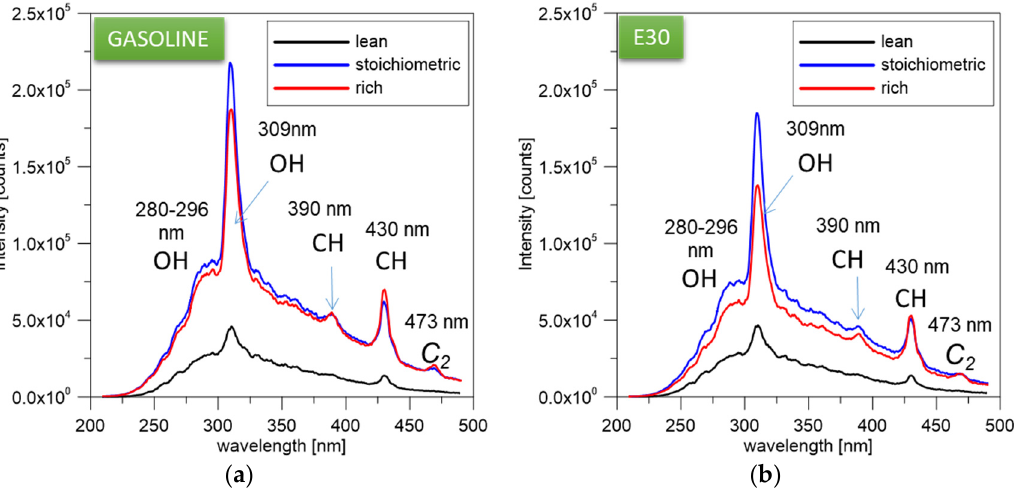
Figure A3. UV-VIS flame emission spectra detected at the selected CAD for: ( a ) Gasoline; ( b ) E30.